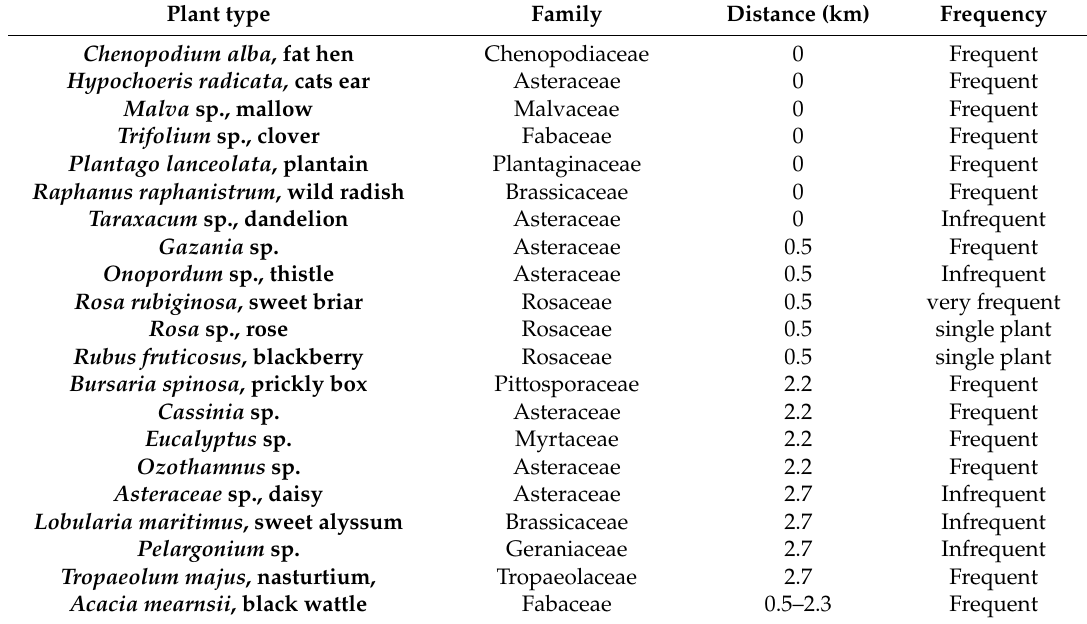
Table 2. Plant types observed in surrounding district to experimental plot. Infrequent <10 plants observed, frequent 10–50 plants observed, very frequent >50 plants